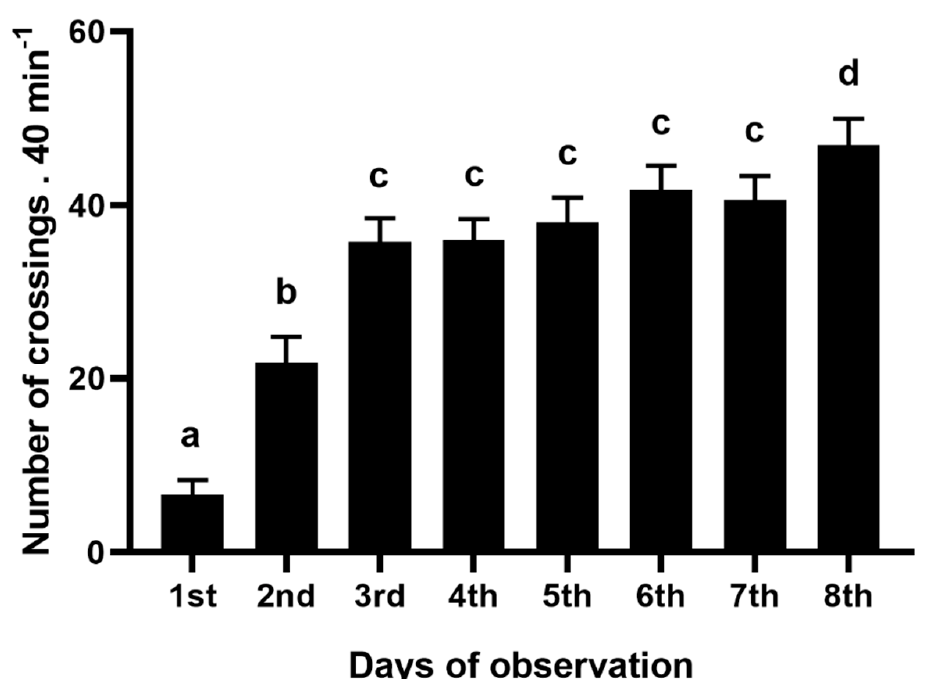
Figure 3. Prior exposure to tactile stimulation. Number of crossings through the tactile bristles